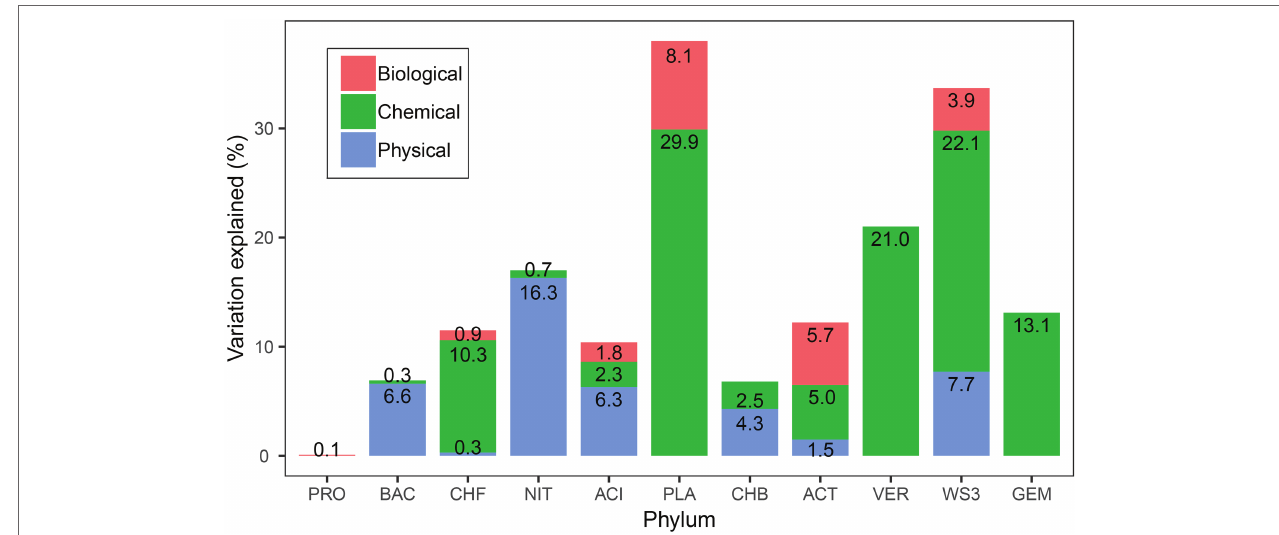
FIGURE 4 | The proportion of the variance in bacterial phylum relative abundance explained by physical, chemical, and biological variables. For simplicity, the pure effects of the three components in predicting the relative abundance are shown, but not the joint effects or unexplained variances. An alternative version of this figure showing the unique and shared variance of each group can be found in Supplementary Figure S1